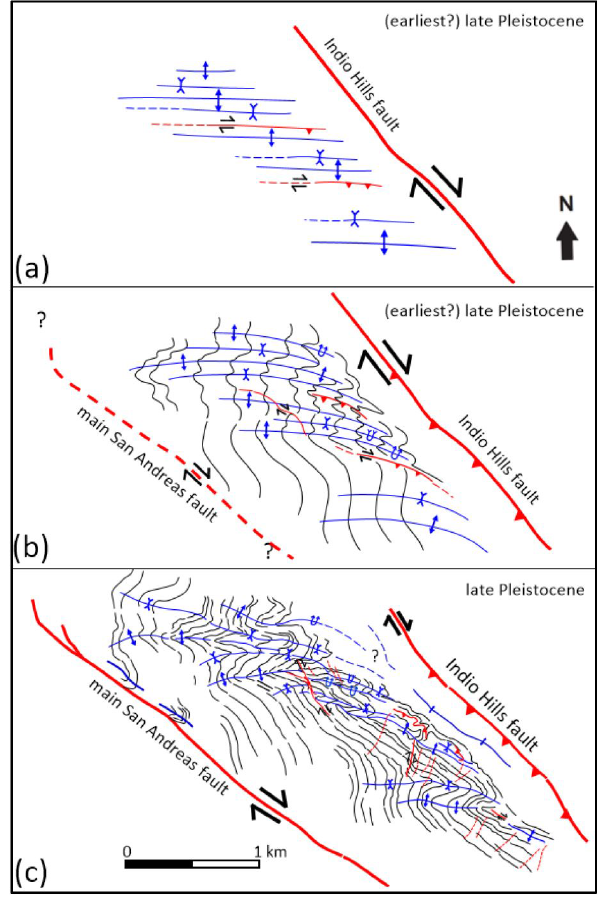
Figure 7. Model illustrating the progressive uplift/inversion history of the Indio Hills presuming a narrow time interval between for- mation of all structures in the area, except for the main San An- dreas fault and associated folds. (a) Early distributed transpressional strain and formation of three major en echelon-oriented macro- folds, several subsidiary parasitic anticline–syncline fold pairs, and bed-parallel strike-slip and reverse (décollement) faults initiating at a high angle (ca. 45 ◦ ) to the Indio Hills fault. (b) Incremental partly partitioned transpression when the Indio Hills fault started to ac- commodate oblique-reverse movement forcing previous horizontal en echelon macro-folds and parasitic folds to tighten, overturn, and rotate into steeper westward plunges. Note also sigmoidal rotation of axial traces on the back limbs of the macro-folds to low angle ( < 20–30 ◦ ) with the Indio Hills fault. (c) Late-stage advanced strain partitioning with dominant shortening component on the oblique- reverse Indio Hills fault and right-lateral slip on the main San An- dreas fault. Notice the formation of the anticline parallel to the Indio Hills fault, subsidiary fold-internal strike-slip faults, and conjugate cross faults and kink bands that overprinted the macro-folds. Leg- end as in Fig.